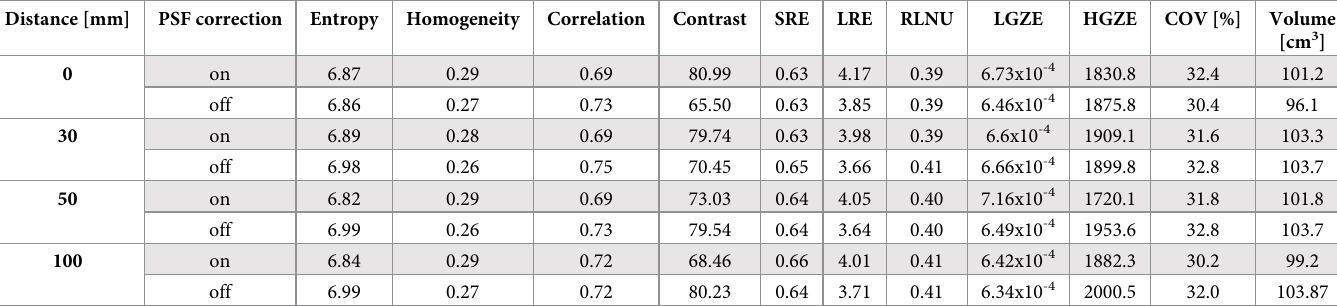
Table 3. The value of heterogeneity parameters of the same texture acquired in different positions in the field of view. Distance [mm] PSF correction Entropy Homogeneity Correlation Contrast